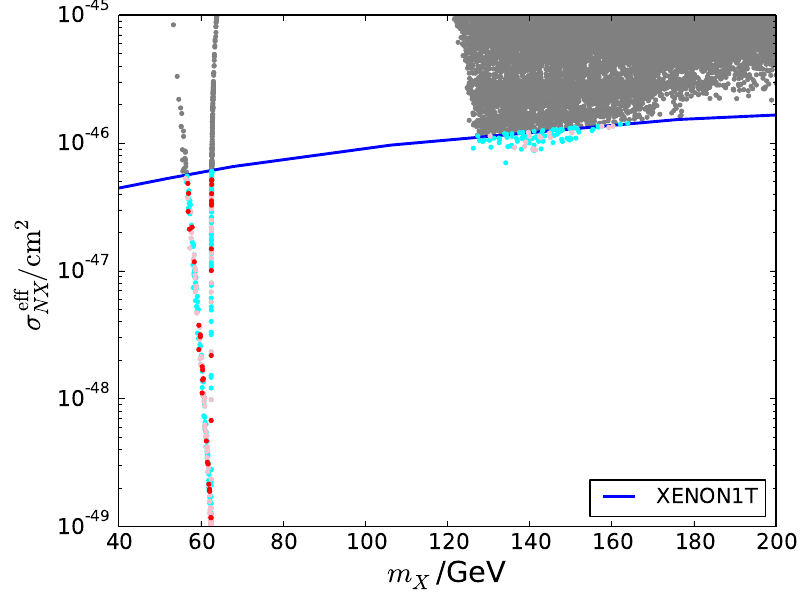
Figure 3 . The projected parameter space in the m X - (cid:27) e(cid:11) is the same as that in (cid:12)gure 2. The blue solid curve represents the most recent XENON1T upper limits on the spin-independent DM-nucleon cross sections.